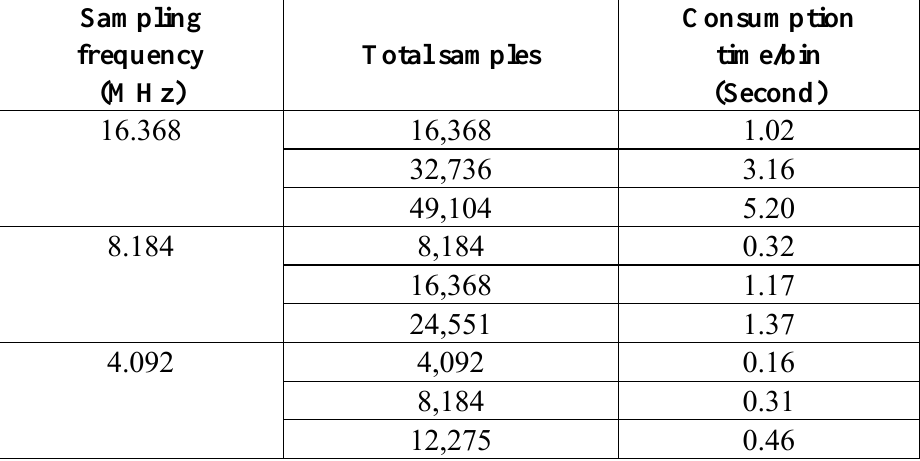
Table 5. The computation cost of the SEV